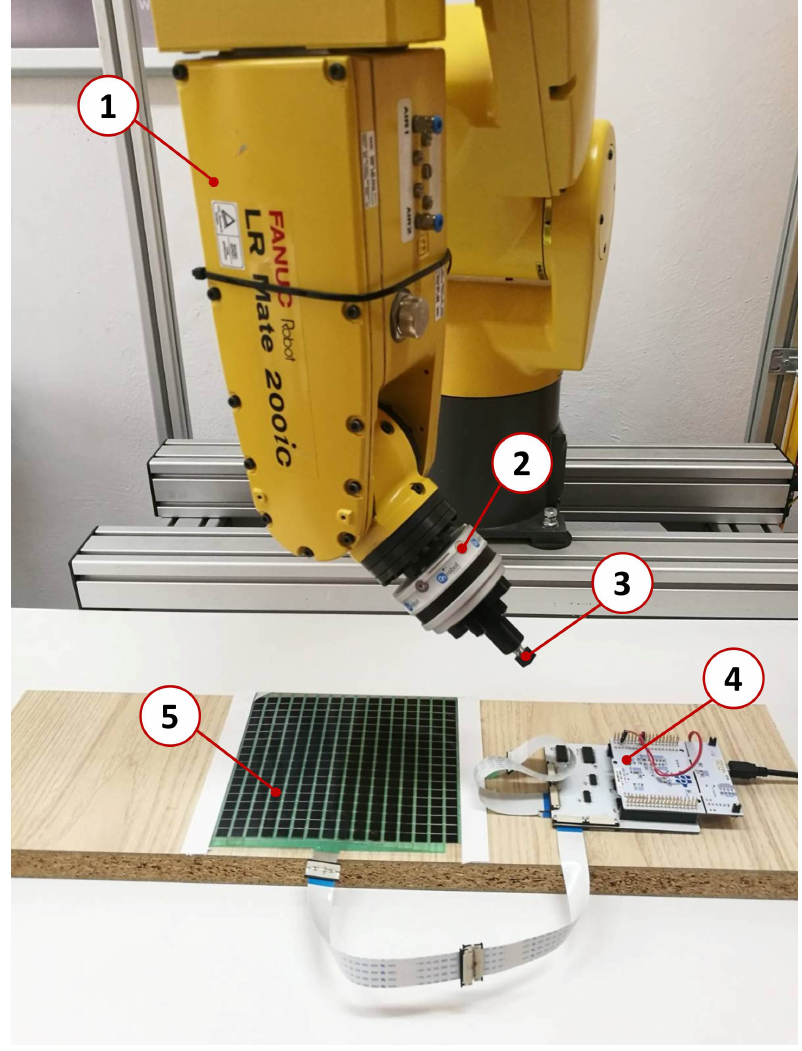
Figure 5. Illustrative representation of the calibration station: 1. LRMate 200iC manipulator, 2. refer- ence e-Hex sensor, 3. robot tool, 4. e-skin electronic system, 5.